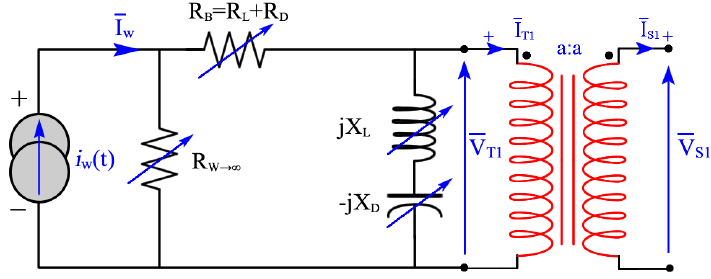
Figure 10. Equivalent diagram for a single blade coupled to the shaft.